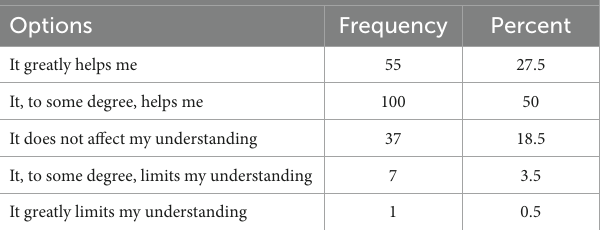
TABLE 5 Participants’ perceptions of Chinese culture toward understanding other